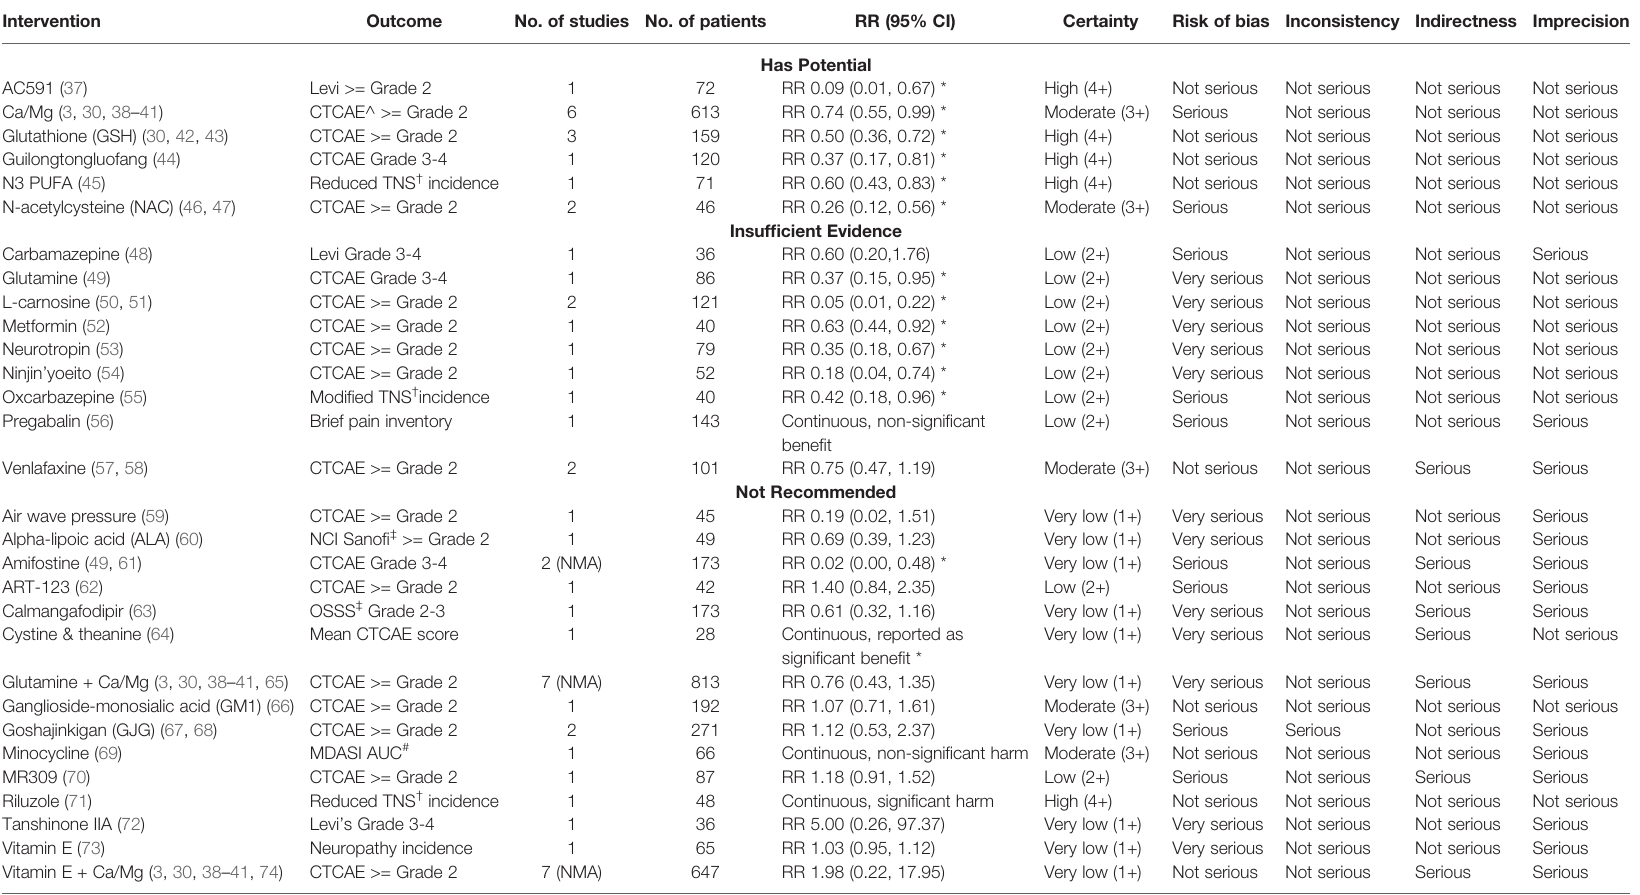
TABLE 1 | Categories of